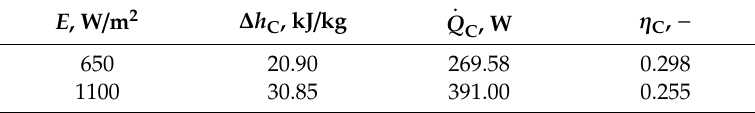
Table 5. Overall performance and e ffi ciency of the solar thermal collector.